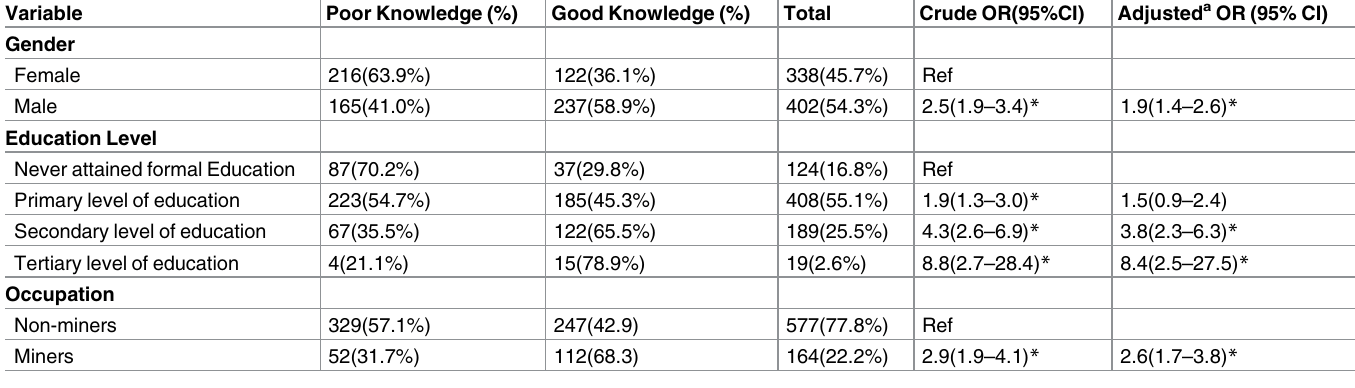
Table 4. Logistic regression model for predictors of knowledge about EVD and MVD in Uganda (Hosmer-Lemeshow χ 2 = 1.31; p-value = 0.93, area under the ROC curve = 0.7).